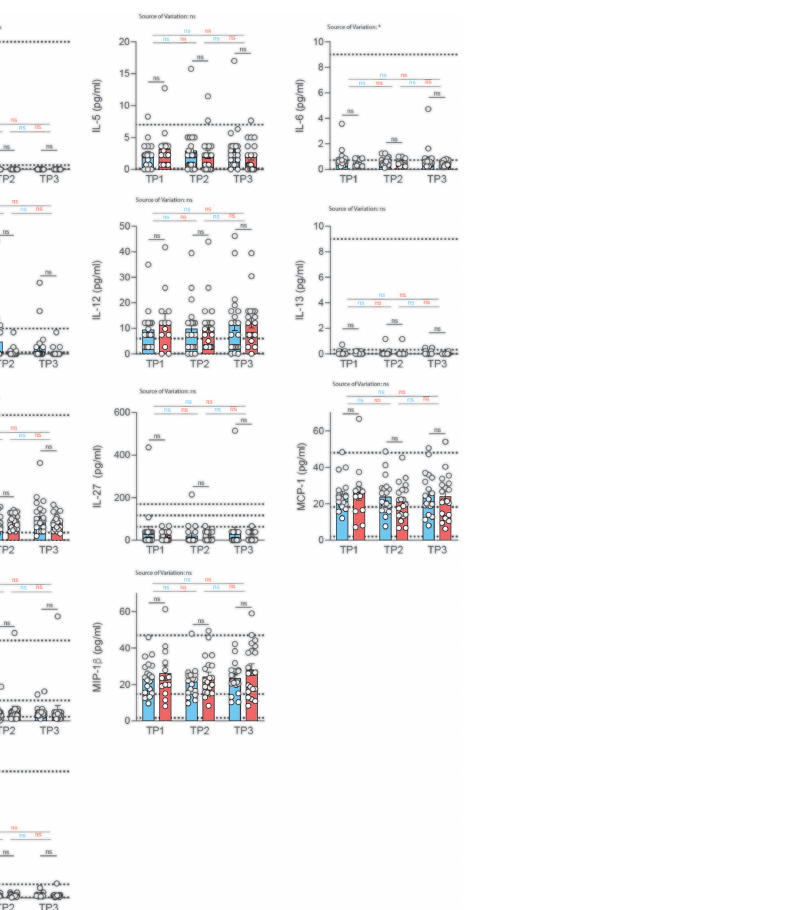
FIGURE 5 | Analysis of serum cytokines over time in COVID-19 patients with different disease severity. Serum was analyzed for cytokines using the multiplex bead array system Bio-Plex. Each circle represents one patient. Horizontal dotted lines indicate the physiological range of cytokine concentrations (low and high range, mean). 2way ANOVA tests with Holm-Sidak ’ s multiple comparisons tests were performed for comparison of mildly versus severely affected patients longitudinally. *P < 0.05; n.s., not signi fi